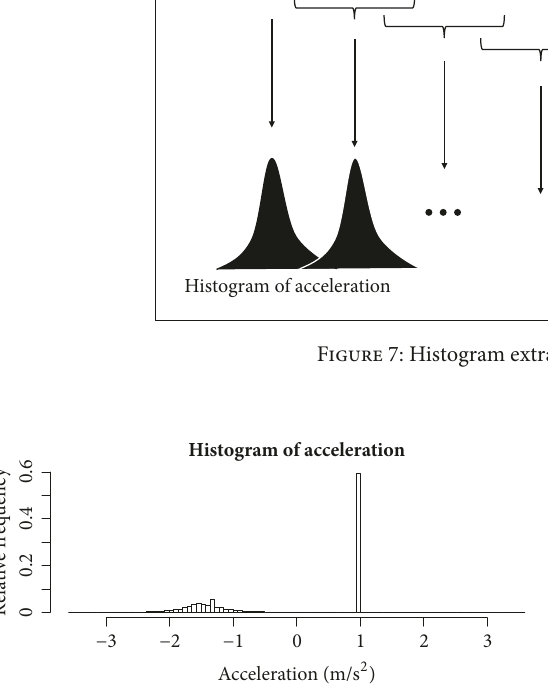
Figure 8: Example of a histogram that contains a glitch.